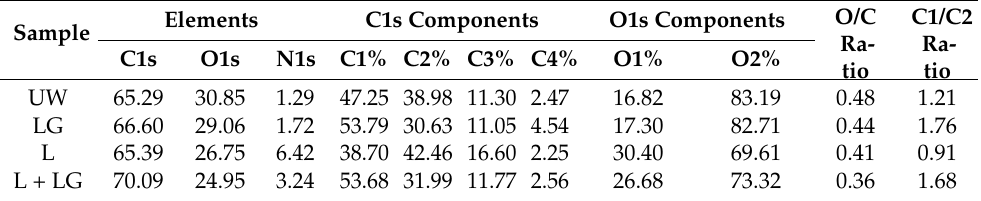
Table 1. Elemental quantification (%) and functional groups relative percent (%) of beech veneers. Untreated beech wood veneers (UW); beech veneers treated with lauryl gallate (LG); treated with laccase (L); treated with laccase and lauryl gallate (L +